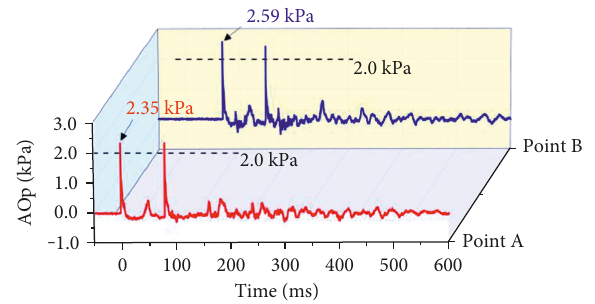
Figure 9: Pressure profiles of point A and point B.